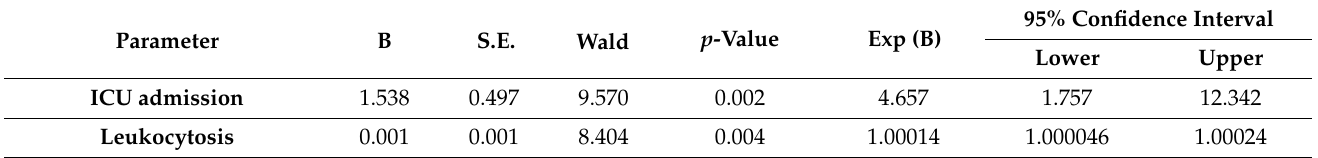
Table 7. Multivariate logistic regression analysis of bacterial infection risk factors.